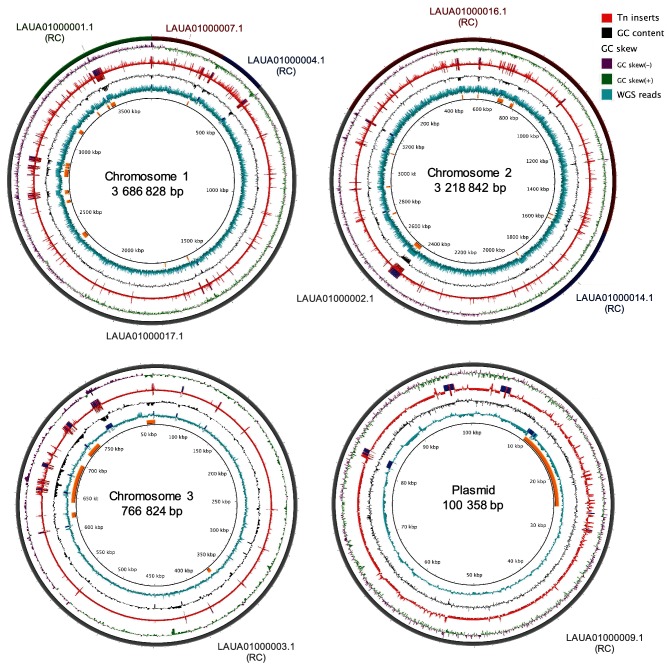
Distribution of reads in the HDTM library mapped to the B. cenocepacia K56-2 genome. From the outermost ring inwards. Ring 1: Contigs from the B. cenocepacia K56-2 assembly aligned to B. cenocepacia J2315 replicons using progressiveMauve [107]; RC, Reverse complemented. Ring 2: GC skew, positive (green), negative (purple). Ring 3: Alignment of reads from Tn-seq (Tn inserts, red). Ring 4: G+C content (black). Ring 5: Alignment of reads from the whole genome sequencing of B. cenocepacia K56-2 prepared with the Nextera XT kit (whole genome sequencing reads, turquoise). Rings 3 and 5: Genome regions with read coverage more than one standard deviation from the mean read coverage are indicated by blue regions. The innermost ring is the bp maker, with the genomic islands indicated by yellow arcs. Replicons are not to scale. Figure created using blast Ring Image Generator (BRIG 0.95) [108].